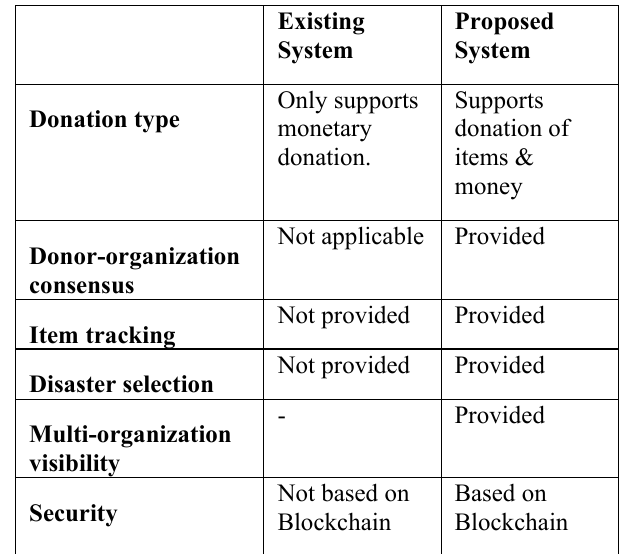
Table 1. Comparison between existing and proposed